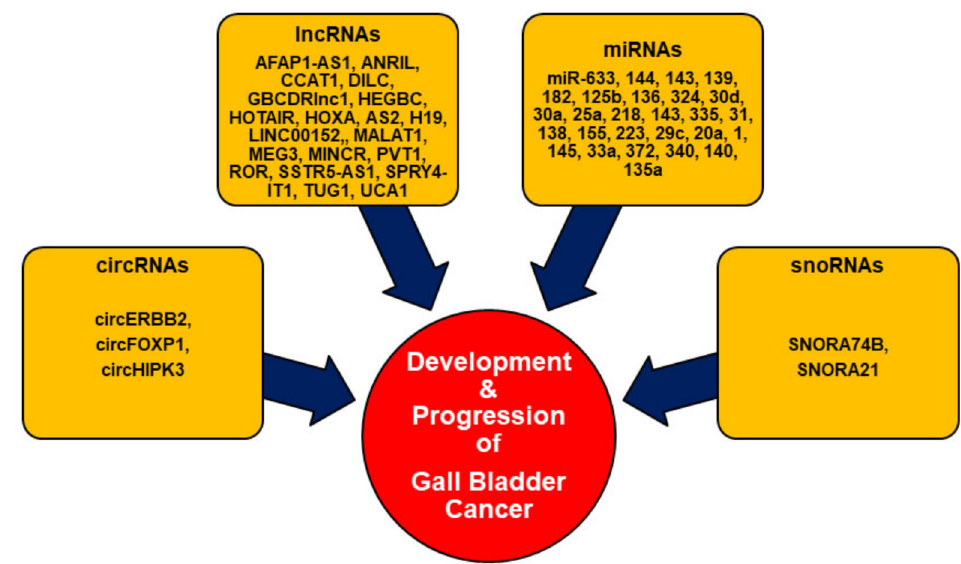
Figure 1. Regulatory ncRNAs in